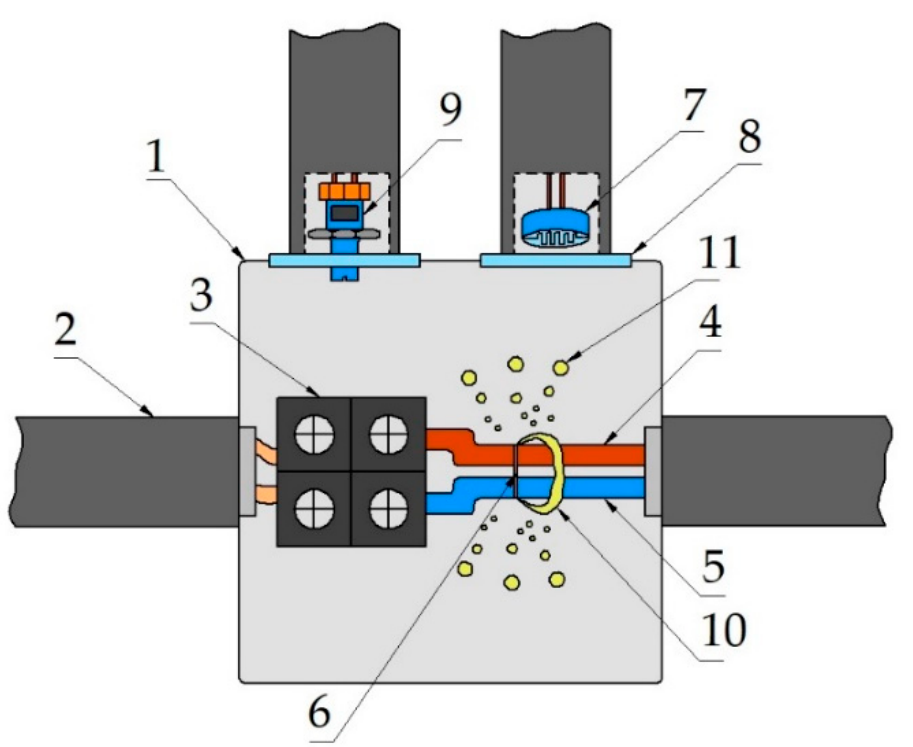
Figure 2. Construction of the arc generator: 1—Surface mounted electrical junction box; 2—PVC tube for electrical installations ( ϕ = 16 mm) for entry and exit of the supply lines, as well as sensors; 3—Terminal strip for quick replacement of the arc generator electrodes; 4—Phase power wire; 5—Neutral power wire; 6—Fusible wire initiating the ignition of the arc; 7—Arc flash detector; 8—Glass, insulating protection of the flash detector; 9—Gas pressure sensor inside the electrical junction box; 10—Arc fault; 11—Drops of glowing material, which constitute the weight loss of the measuring electrodes.